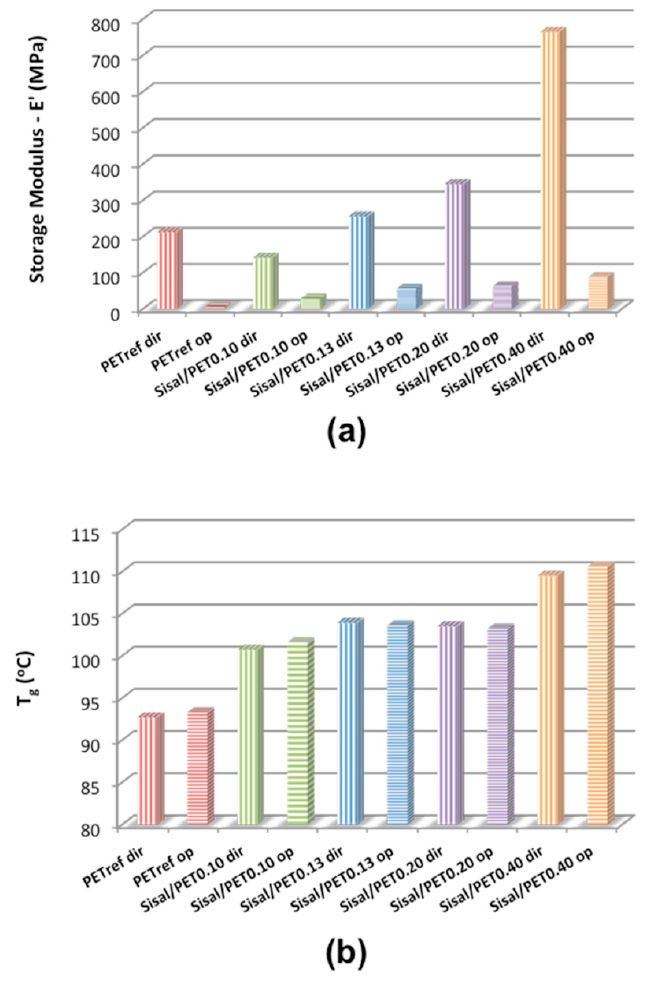
Figure 7. ( a ) Storage Modulus (at 30 °C) (errors from ±0.90 (Sisal/PET 0.13 op ) to ±50.10 (Sisal/PET 0.13 dir )) and ( b ) T g values (errors from ±0.04 (PET ref op ) to ±0.90 (Sisal/PET 0.20 op )) of the electrospun mats. All materials were characterized in the preferential direction of fiber alignment (acronyms containing “ dir ”), and in the opposite direction of fiber alignment (acronyms containing “ op